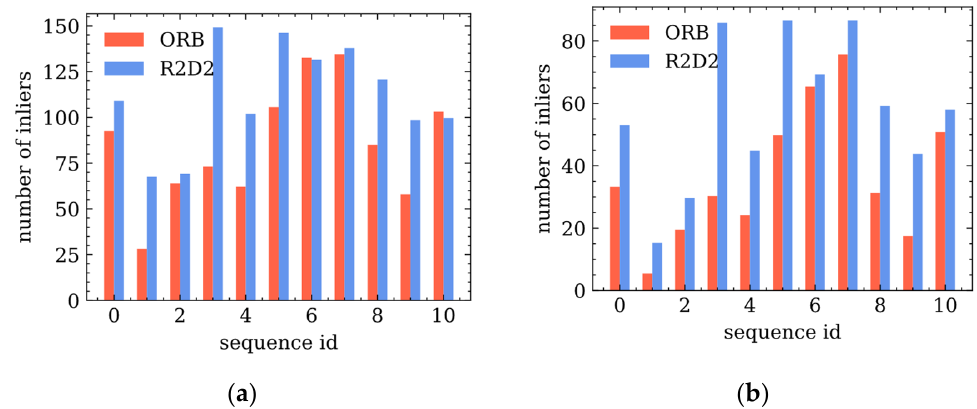
Figure 5. Tracking inliers comparison of ORB and R2D2 feature extraction. The x-axis is the index of each sequence in the KITTI dataset. ( a ) The average number of inliers with a 10-frame interval. ( b ) The average number of inliers with a 20-frame interval.